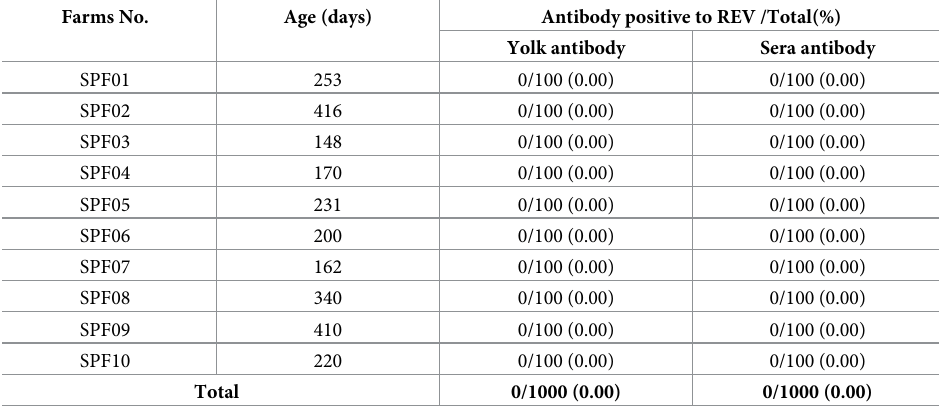
Table 3. Detection of REV antibody from 10 SPF chicken flocks in China (random collection). Farms